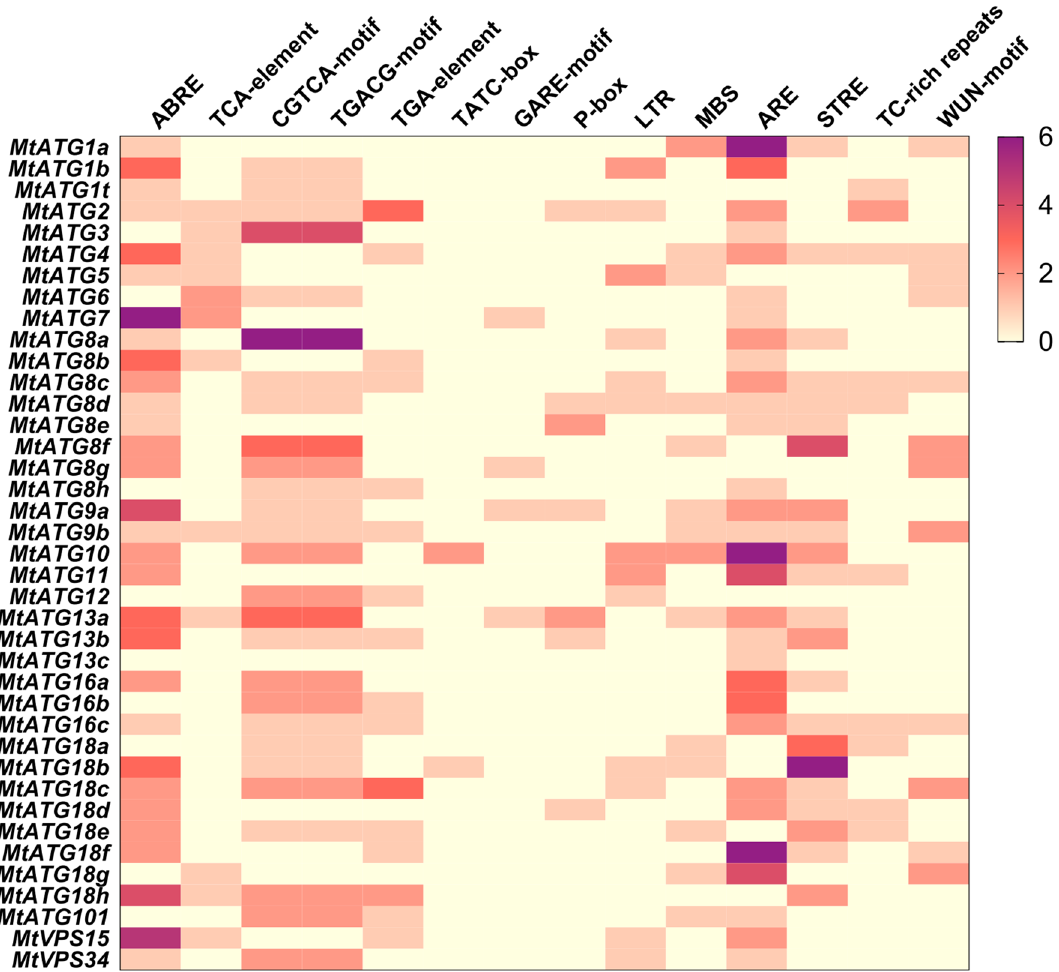
Figure 4. The number of cis-elements in promoters of MtATGs . The assumed cis-elements of MtATGs predicted using the PlantCARE web servers, and the number of cis-elements in each promoter of MtATGs are visualized using a heatmap generated with GraphPad Prism